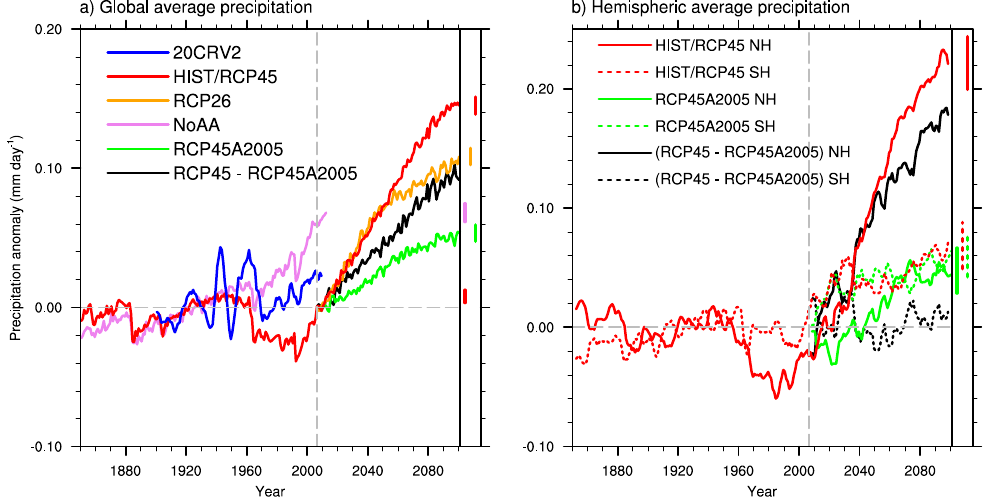
Fig. 7. Anomalies (relative to the 1850–1899 mean) of annual-mean, ensemble-mean precipitation from the model: (a) global means, (b) NH and SH means. In panel (a) , the blue curve shows a reconstruction of global-mean precipitation anomalies for 1900–2009 (20CRv2; Compo et al., 2011). In both panels, differences between RCP45 and RCP45A2005 are shown as black curves, and the vertical dashed line at 2006 marks the start of the projections. The vertical bars in the right inset show the standard deviations of the mean precipitation from the last 10yr of each experiment (2091–2100 for the projections, or 2003–2012 for HIST and NoAA). A five-year running mean was applied to reduce noise in panel (b) and for the 20CRv2 data in panel (a)